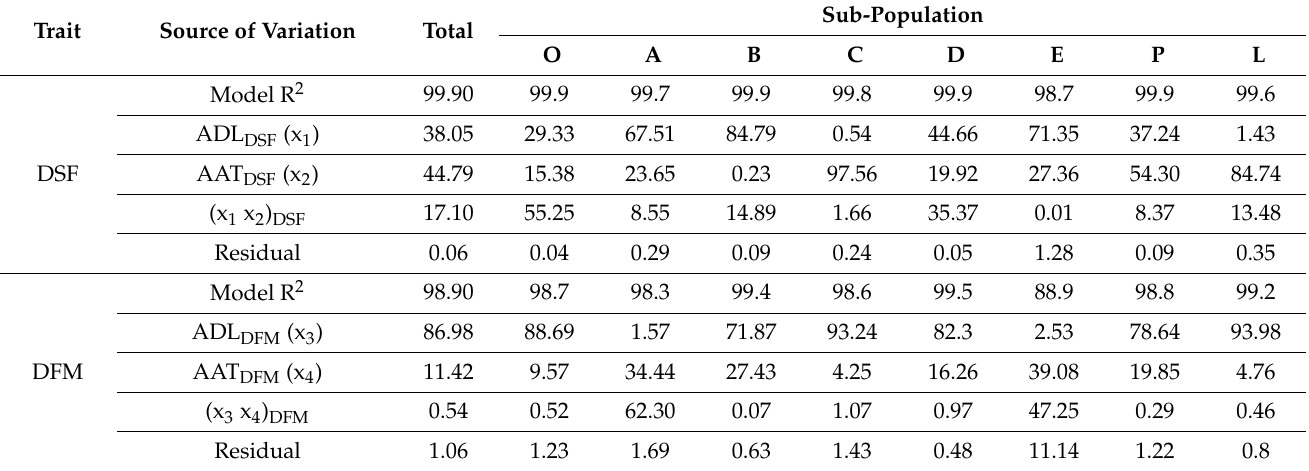
Table 3. Decomposition of determination coefficient in multiple regression analysis of growth period traits on accumulative day length, accumulative active temperature and their